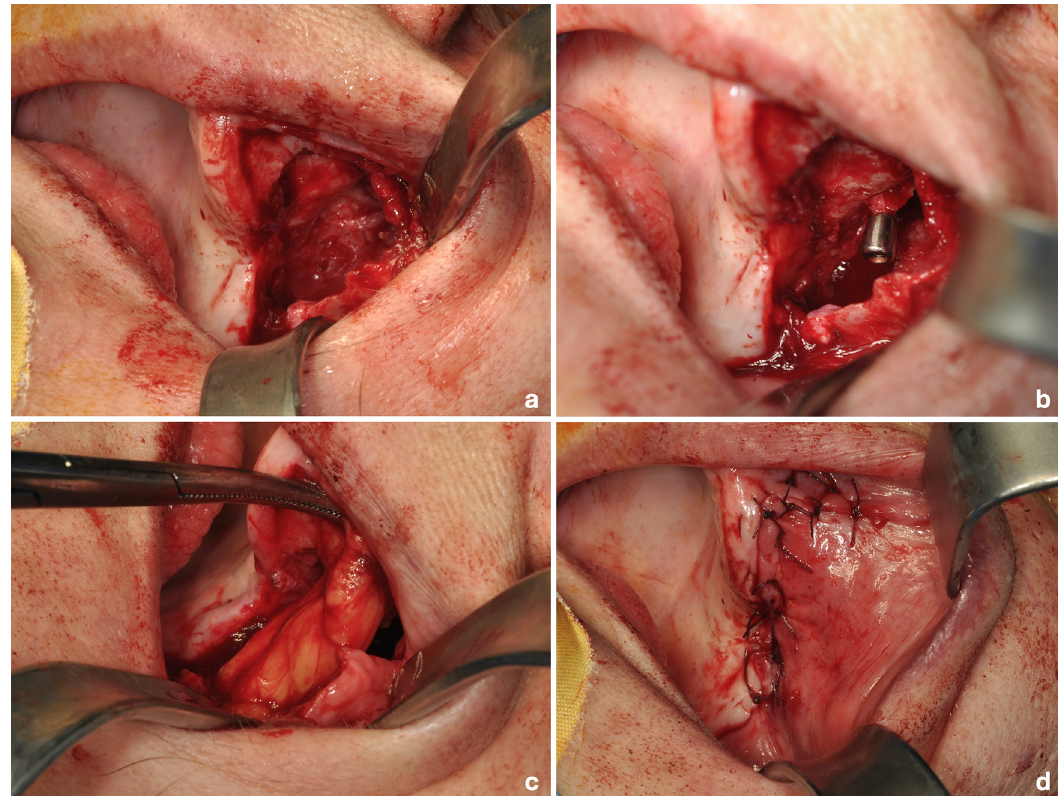
Fig. 3. Per-operative photographs. (a) Full thickness fl ap detachment showing the bone defect. (b) Antrostomy of the middle meatus. The suction canula can be seen through the middle meatus (c) Rotation of the buccal fat pad. (d) Closure with absorbable